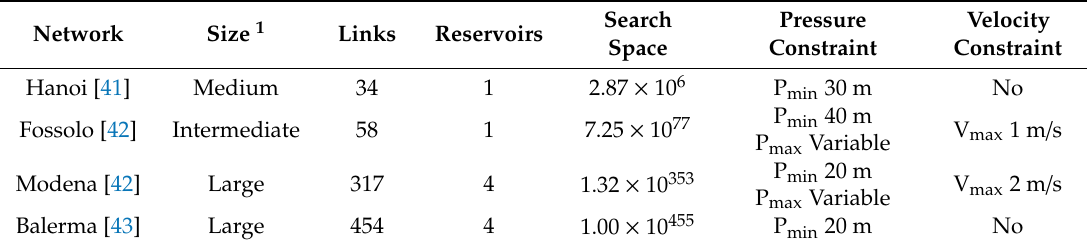
Table 1. Characteristics of the networks used as study